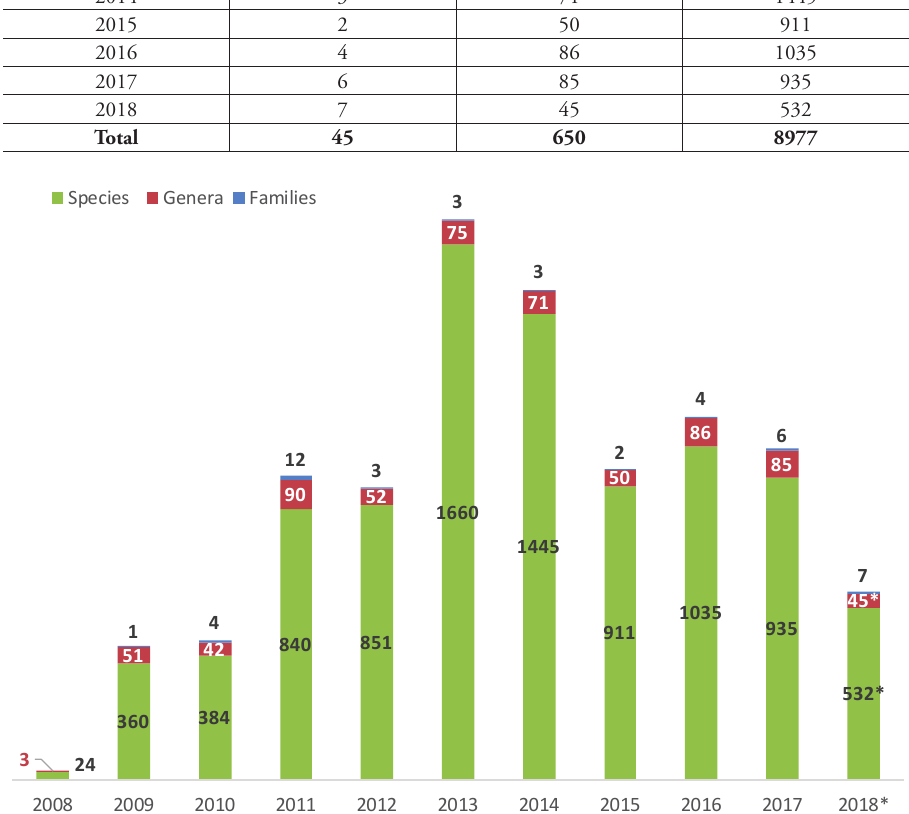
Figure 2. New taxa published in ZooKeys, registered in ZooBank (courtesy of Richard Pyle; *until 27.6.2018).